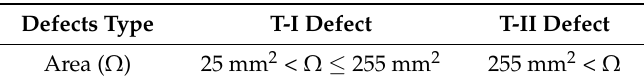
Figure 9. Examples of UAV images containing discrete defects on rail surfaces. Table 1. The type of rail surface defects.